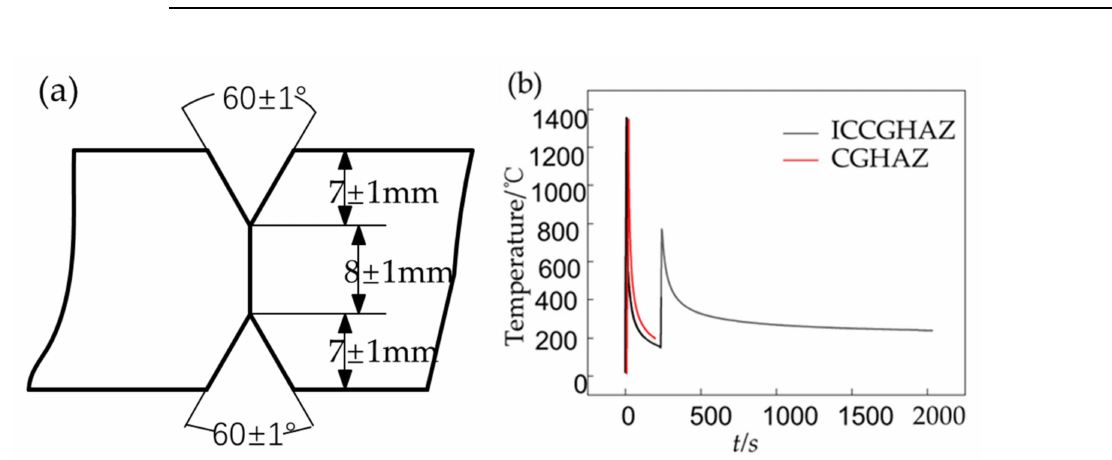
Figure 1. ( a ) the groove of the weld joint; ( b ) the thermal cycle curves of simulated CGHAZ and